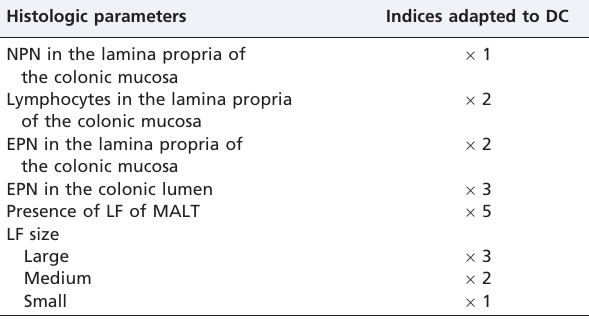
Table 2 - Cell types, assessment of lymphoid follicles of mucous associated lymphoid tissue (MALT), and respective values proposed by the Myers index modified for conversion into absolute numbers.